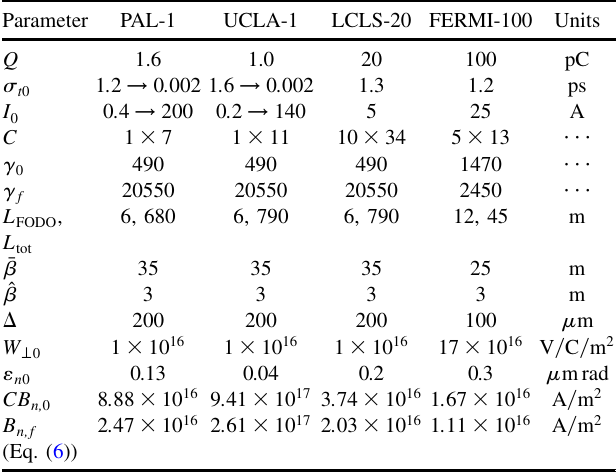
TABLE II. Ultralow charge beam and machine parameters. The peak current I 0 is defined as Qc divided by 3 : 5 (cid:4) z; 0 . The normalized emittance is the geometric mean of the horizontal and the vertical values. The (cid:1) 1 pC bunch length is initially compressed with velocity bunching ( ! ) as described in [37,38]. The magnetic compression is set to obtain a final peak current of 1.5 kA in all